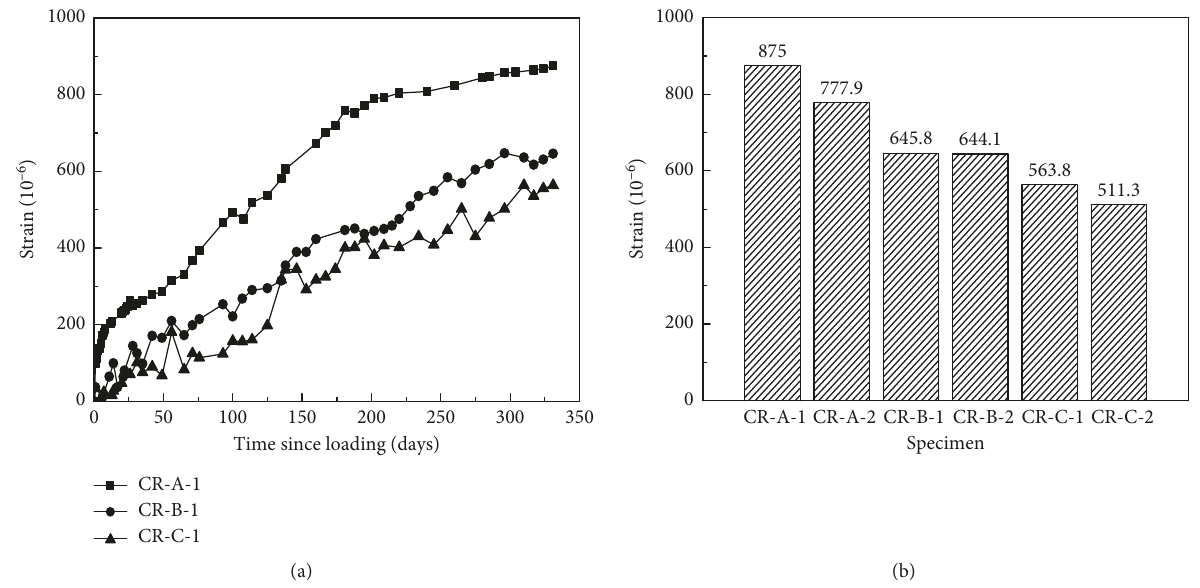
Figure 9: Creep strains of the specimens under different exposure conditions: (a) comparison of creep strain curves; (b) comparison of creep strain at 331 days since